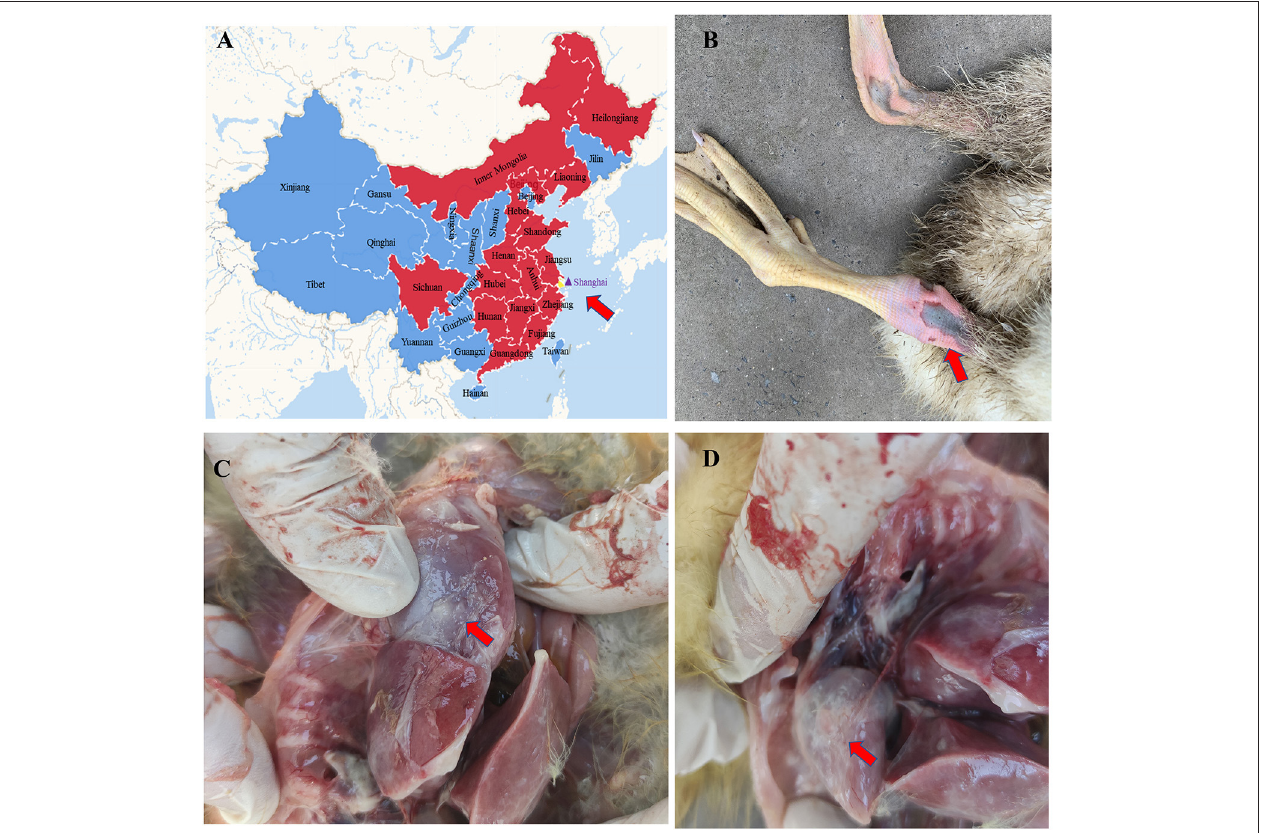
FIGURE 1 | Goose astrovirus distribution in China and pathological lesions of clinical samples. (A) Goose astrovirus distribution in the different provinces of China. (B) Gosling died of gout. (C,D) Urate deposits in kidney and liver.